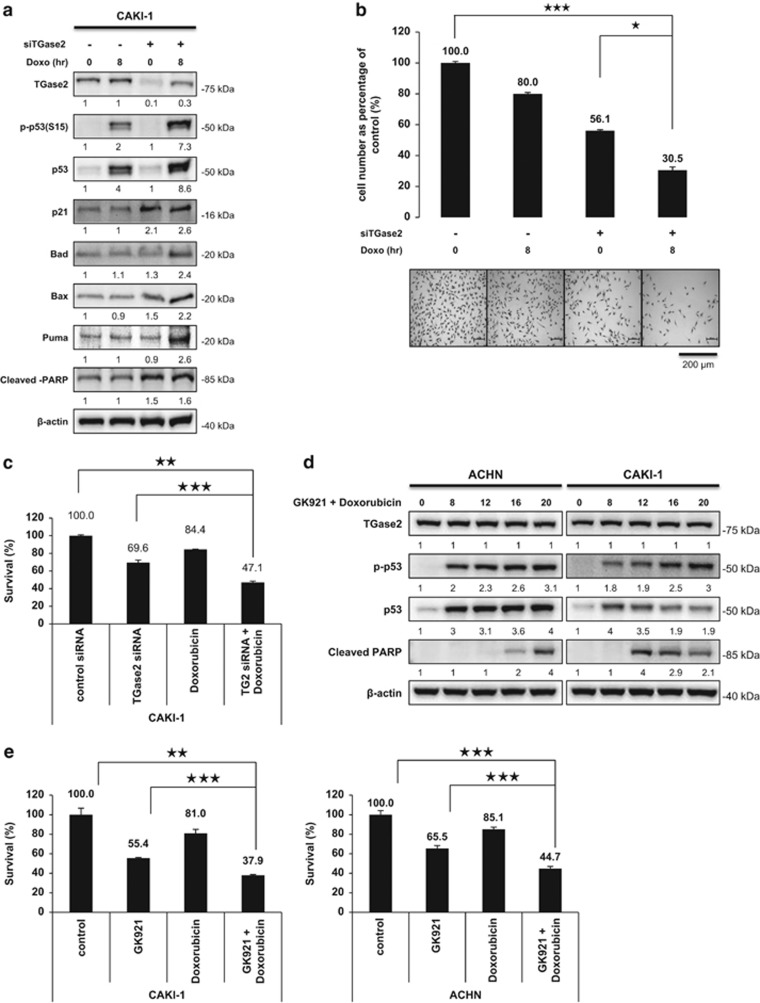
Doxorubicin potentiates the apoptotic effects of TGase 2 silencing by extending p53 stability. (a) CAKI-1 cells were treated with siTGase 2 for 48 h, and then with doxorubicin for an additional 8 h before harvesting for immunoblotting of TGase 2, p53 and downstream markers of p53. (b) Viable cell was counted by using SRB staining after a single treatment of control siRNA, siTGase 2, or doxorubicin (1 μM), or a combined treatment of doxorubicin (1 μM) and siTGase 2. Y-axis presents viable cell per square mm. (c) To measure combination effect of doxorubicin with TGase 2 knockdown against RCC growth, XTT assay was employed under same conditions as (b). (d) To measure induction of apoptosis by dual treatments, CAKI-1 and ACHN cells were treated with a combination of GK921 and doxorubicin (1 μM) for 0, 8, 12, 18 and 20 h. Immunoblotting was performed against cleaved PARP and p-p53. (e) To measure combination effect of doxorubicin and GK921 against RCC growth, XTT assay was employed under same conditions as (d). Cumulative data from three independent experiments is shown here as mean±S.D. (n=3). *P<0.05, **P<0.01, ***P<0.001